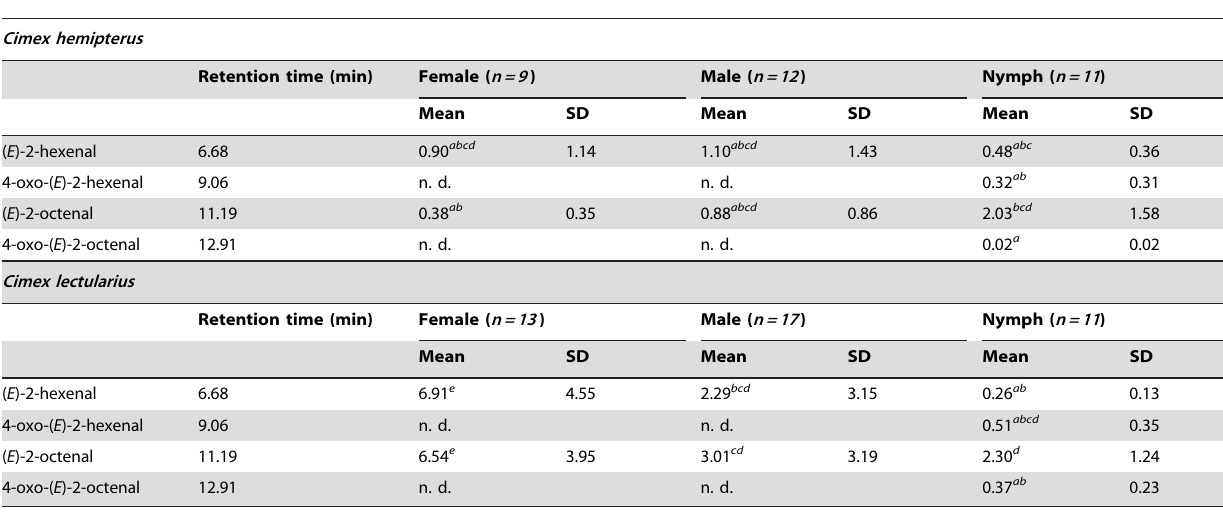
Table 2. Quantification of compounds in head space collections of C. hemipterus and C. lectularius .